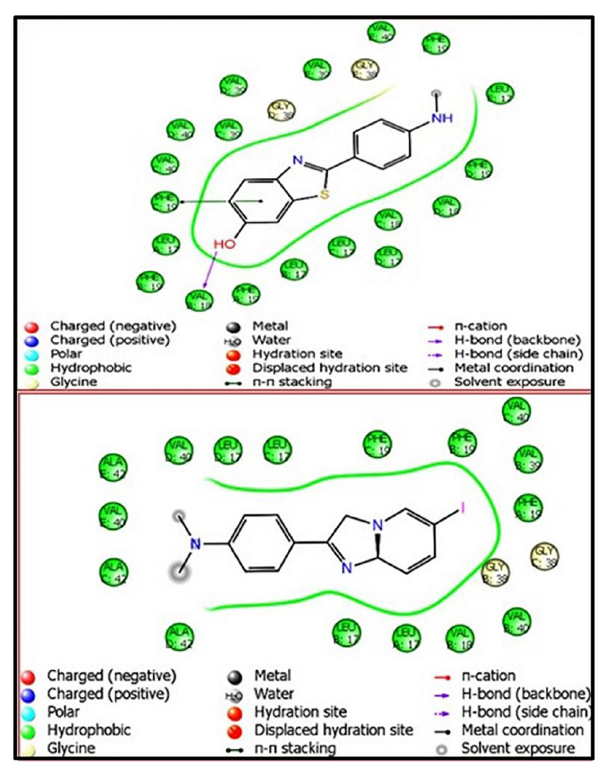
FIGURE 5 | Ligand interaction diagram (LID) of PiB- and IMPY-associated amyloid-beta fibril (2BEG),